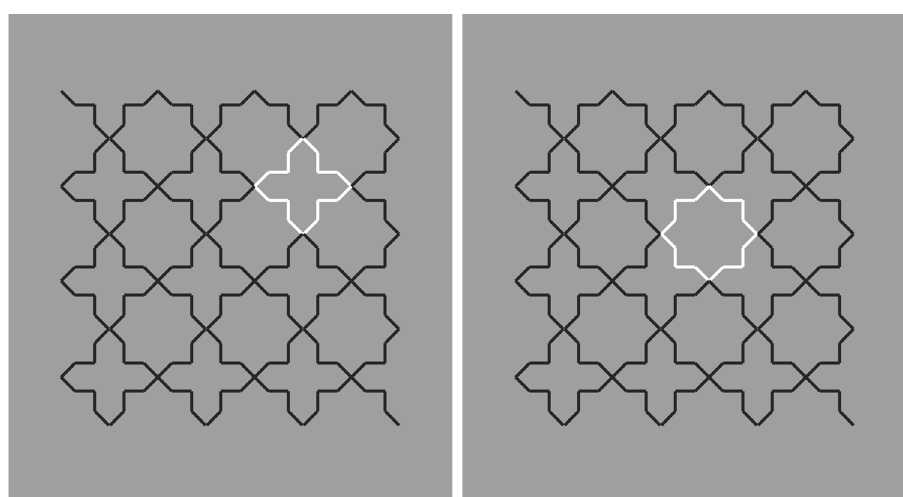
Figure 3. Crosses and stars spreading and filling in.